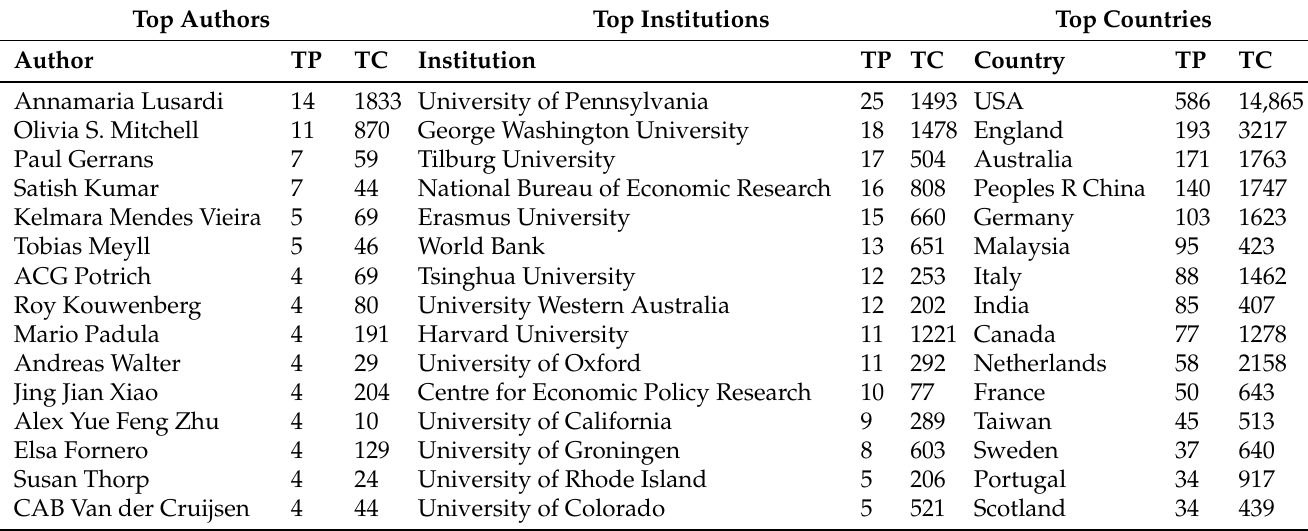
Table 1. Top authors, affiliated institutions, and countries publishing on financial literacy prepared using VOSviewer